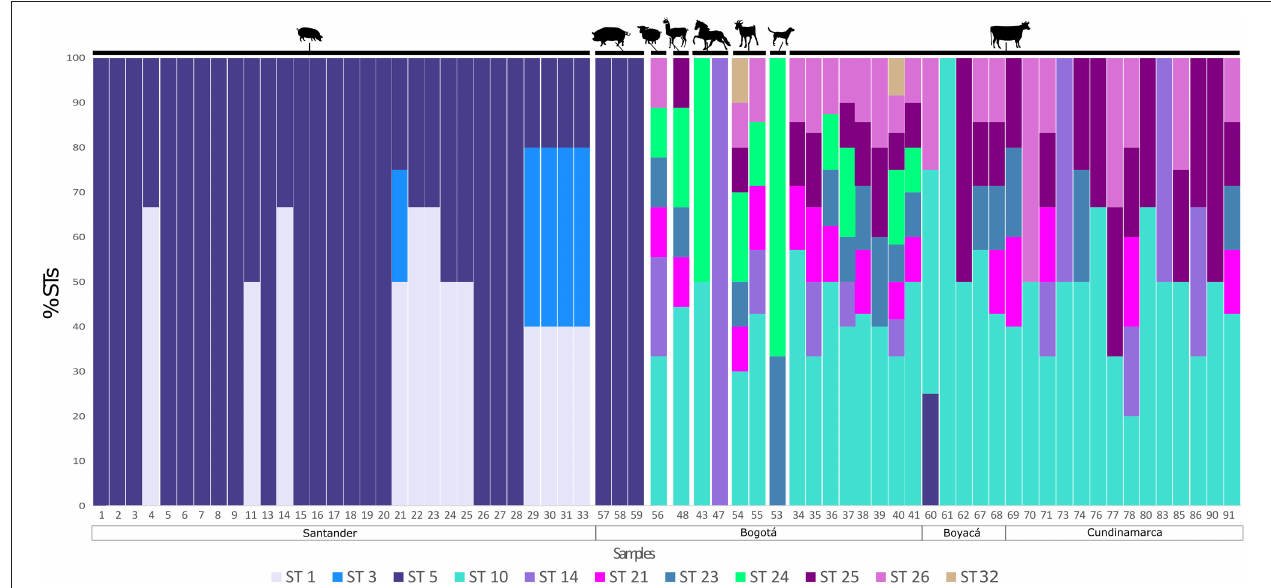
FIGURE 1 | Detection of single and mixed infections in animals. The percentage of each ST detected is shown by sample. Each ST is highlighted in a different color. The figure is organized by host and location.